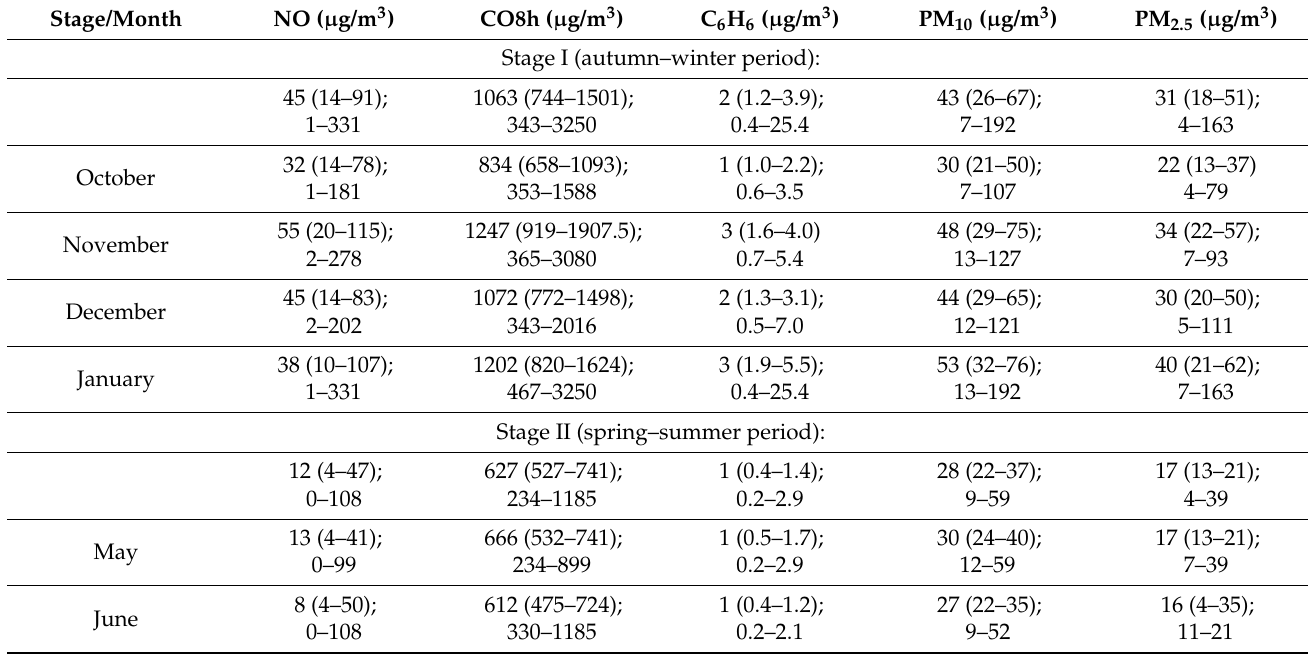
Table 2. The value of air pollution during the period under investigation.